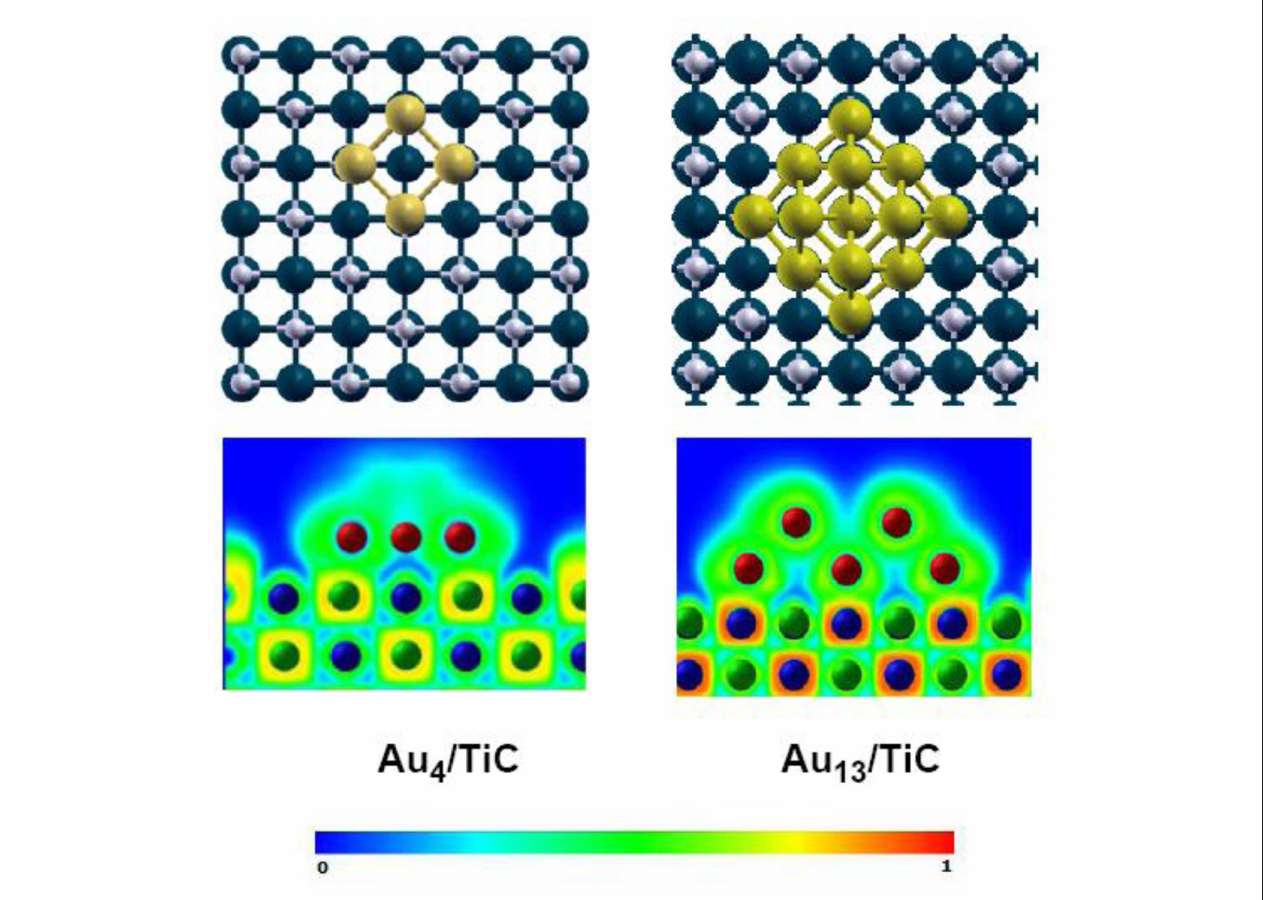
FIGURE 1 | Bonding configurations (top section) and ELF maps (bottom section) calculated for Au 4 and Au 13 clusters on TiC(001) using DF-based methods. Color code: Carbon atoms are represented by gray spheres, titanium atoms as blue spheres, and gold atoms as yellow spheres. The Au 13 cluster contains two layers of 9 and 4 metal atoms. Bottom, ELF maps: The probability of finding an electron varies from 0 (blue color) to 1 (red color). Reproduced with permission from Rodriguez and Illas (2012), copyright 2012 by the Royal Society of